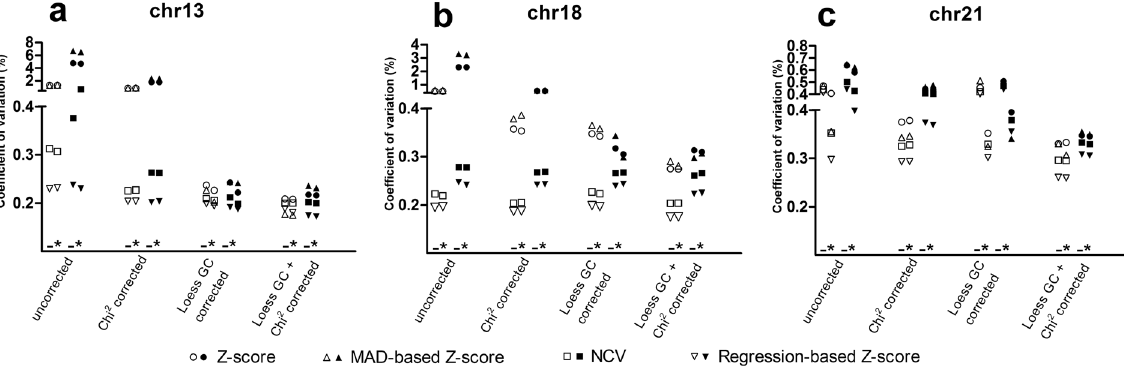
Figure 2. Effect of peak correction on the CV of control samples. The effect is shown for SOLiD (white) and Illumina data (black) with no other correction, for data that also had a chi-squared correction, or LOESS GC correction, or both LOESS GC and chi-squared correction. For each type of correction the CV of four prediction algorithms (standard Z-score, MAD-based Z-score, Normalized Chromosome Value and regression- based Z-score) are shown for ( a ) chromosome 13, ( b ) chromosome 18 and ( c ) chromosome 21. – not peak corrected; * peak